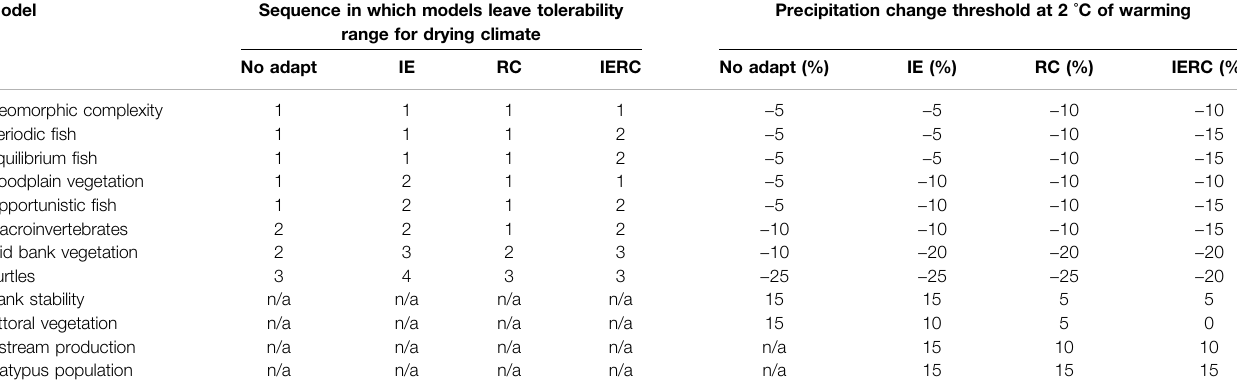
TABLE 4 | Sensitivity of ecological models to changes in long-term annual precipitation for current conditions and each adaptation option. The sequence in which models leave their individual tolerability range is given, as well as the precipitation change threshold when they leave their range. Note that some models leave their tolerability range at the same precipitation change hence their sequence is recorded